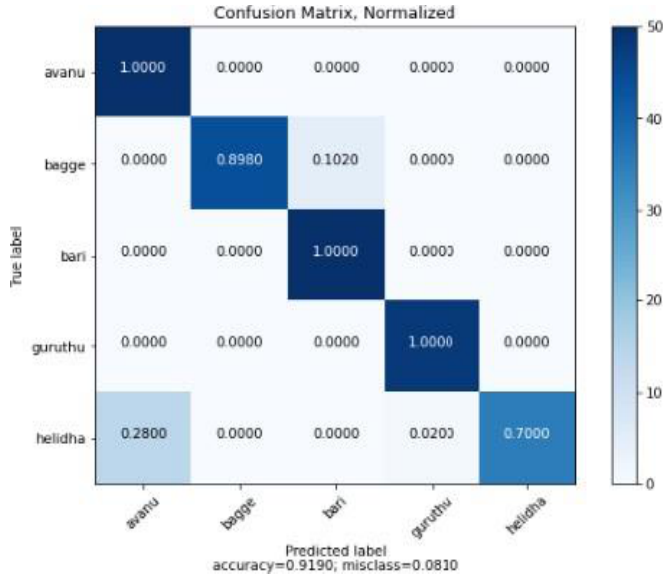
Figure 7. Confusion Matrix for Kannada Database. Table 5. Comparison of Proposed Methodology with other methodologies.